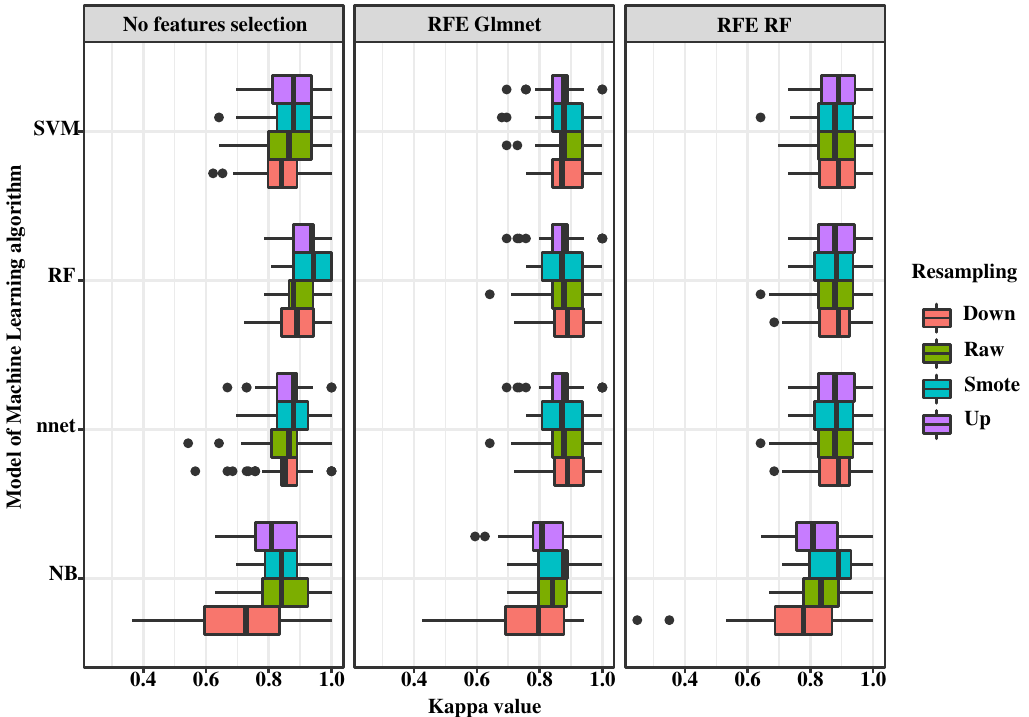
Figure 3. Comparison of Machine Learning algorithms, resampling and feature selection methods to estimate with the Kappa coefficient a classification model on test sets. Notes SVM for Linear Support Vector Machine, RF for Random Forests and, NB for Naive Bayes and nnet for single hidden layer Neural NETwork; Recursive Feature Elimination (RFE) coupled to Random forests (RF) or Logistic Regression (Glmnet) or No selection variable method; resampling methods (Up, Down or SMOTE 8 ) or no sampling method